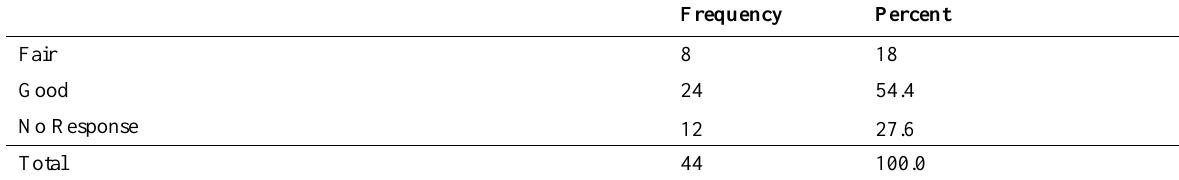
Table 8: Extent of implementation of the plan